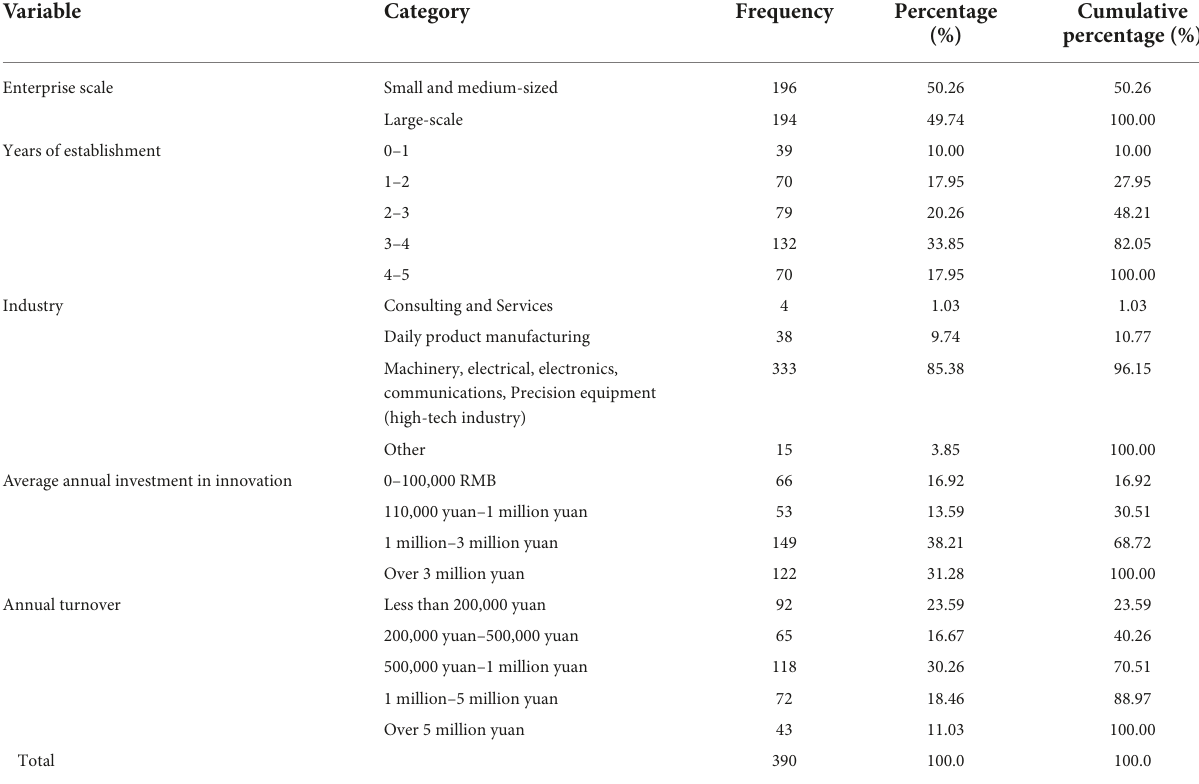
TABLE 1 Demographics of survey